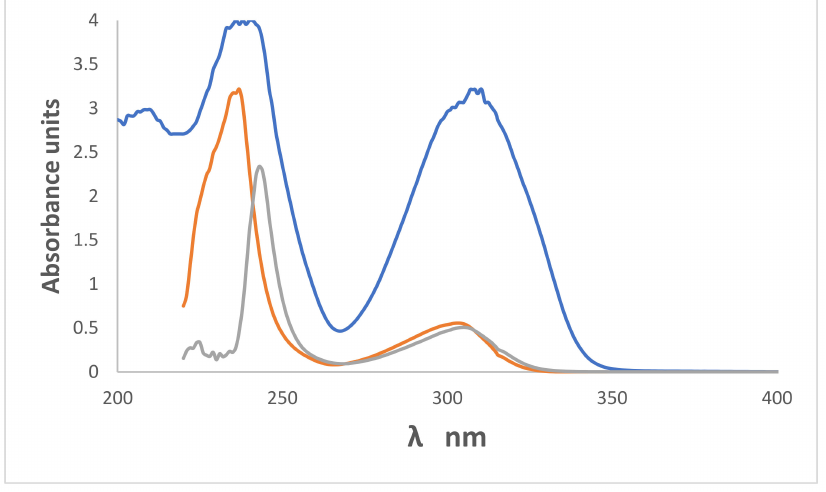
Figure 14. Absorption spectra of 9.2 × 10 − 6 M in CHCl 3 , ethanol and 6.8 × 10 − 5 M of 2-amino-4-hydroxy-6-(4-hydroxy-2-oxo-2H-chromen-3-yl)nicotinonitrile 4 -doped PVA thin film, thickness 100 µ m ( λ ab max at 243, 307 nm, λ ab max at 238, 307 nm and λ ab max at 238, 307 nm, respectively).